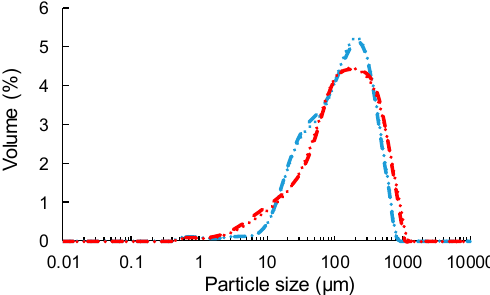
Figure 2. Particle size distribution for ViSh-V (- -), ViSh-E ( · · ), WiPo-V (- -) and WiPo-E ( · · ) in volume. Table 2. Filler density and apparent diameter (in volume).